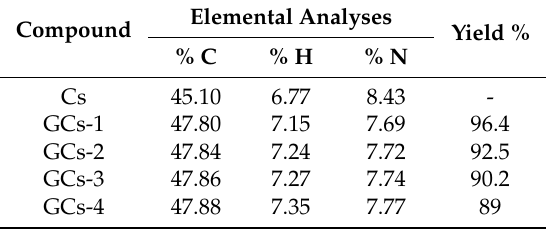
Table 2. Elemental analyses and % yield of G-chitosan hydrogels.